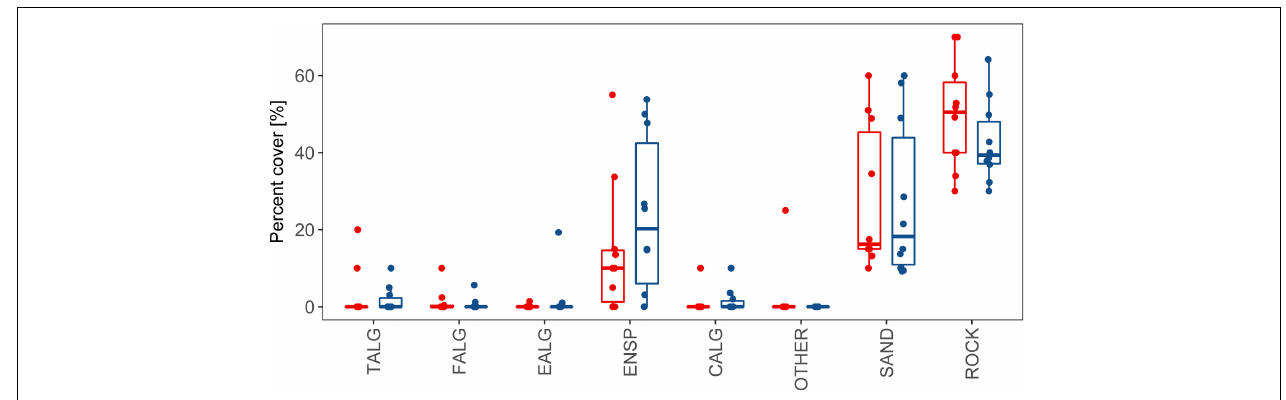
FIGURE 3 | Percent cover of the categories of organisms that colonized or non-biological material that covered the areas of partial mortality in branches of the coral A. palmata during the months of March (red bars) and June (blue bars), 2016. Groupings: TALG, Turf algae; EALG, Encrusting algae; ENSP, Encrusting sponges; CALG, Calcareous algae; FALG, Fleshy macroalgae; SAND, Sand; Substrates: ROCK, Rock; OTHER, Other.